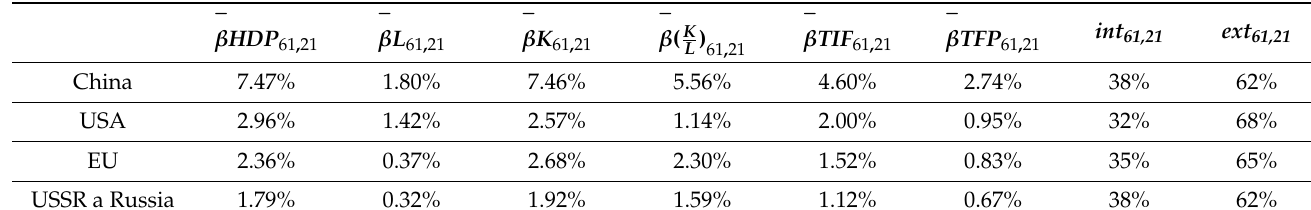
Table 2. Relative changes and the indicators int t and int t for the period from 1961 to 2021.